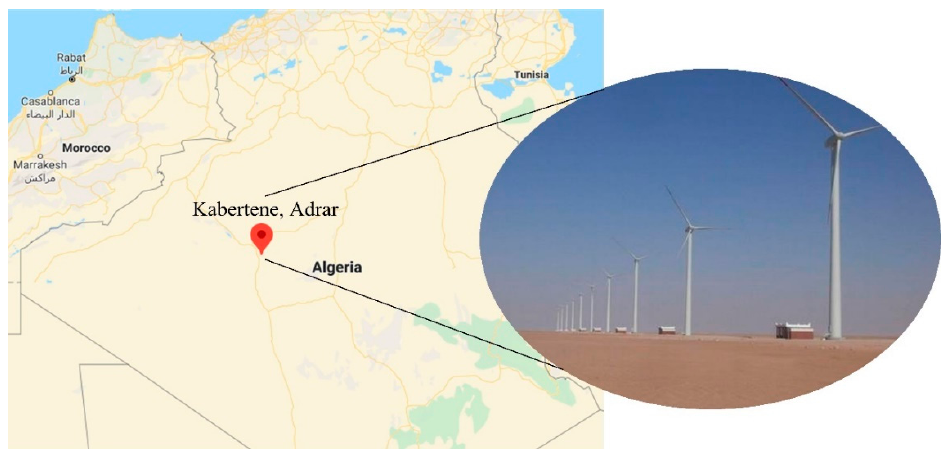
Figure 22. The 10 MW wind power farm in Kabertene, Adrar.